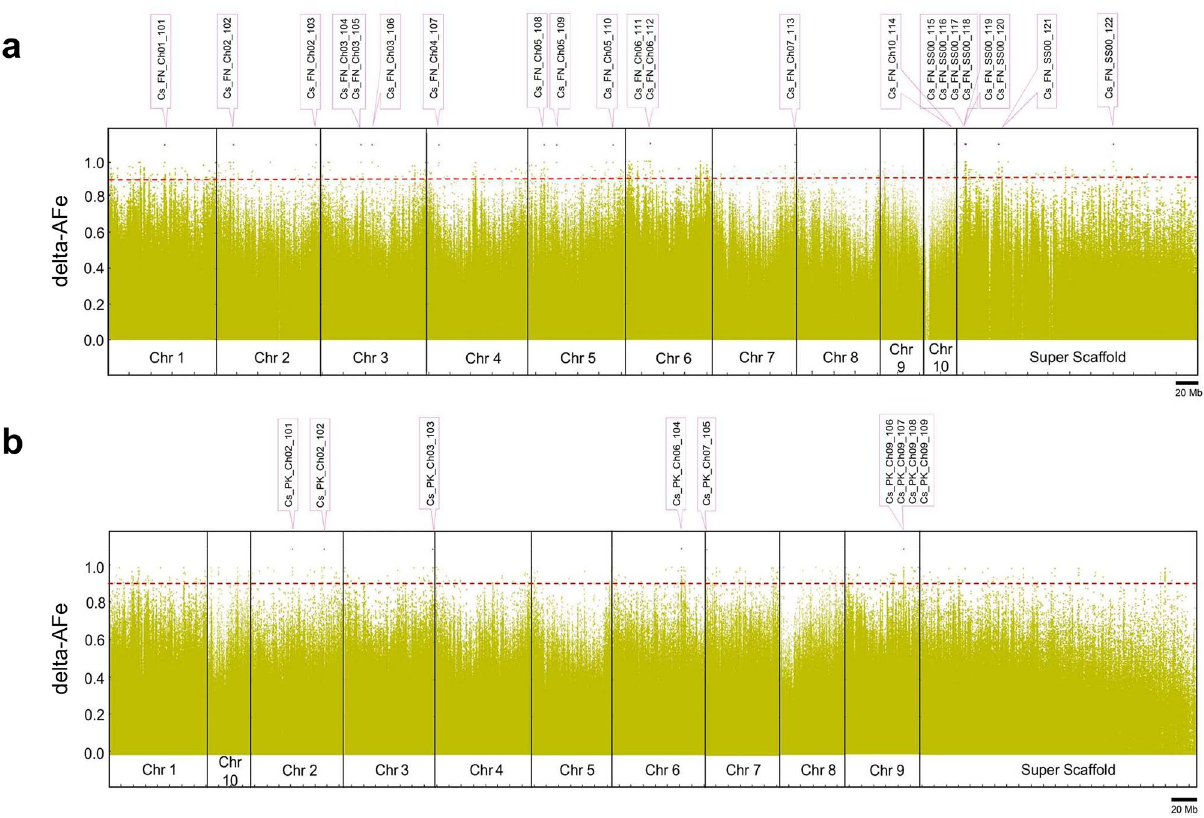
Figure 4. Delta-AFe between chemotypic pools and interval detection. ( a ) Delta-AFe plotted by chromosome number and coordinate along the Cannabis sativa L. var. Finola (FN) genome. Delta-AFe is the absolute difference between allele frequency estimates of CBDA and THCVA DNA pools. ( b ) Delta-AFe plotted by chromosome number and coordinate along the Cannabis sativa L. var. Purple Kush (PK) genome. Intervals displaying delta-AFe values of ≥ 0.9 were delineated using an algorithm which plots contiguous AFe values ≤ 0.1 in the CBDA pool (see “Methods”). To reduce background noise, only delta-AFe supported by 0.75–2.5 × the average depth of coverage was plotted. Pink lines indicate location of intervals. Red dotted line indicates delta- AFe of 0.9; AFe allele frequency